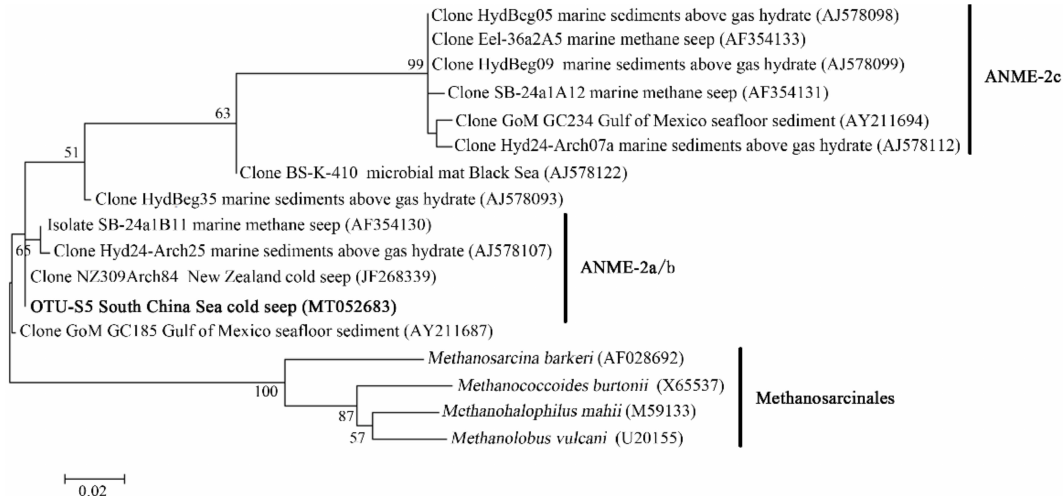
Figure 5. The maximum-likelihood phylogenetic tree based on 16S rRNA gene sequences (391 bp) showingthepositionofOTU-S5fromthisstudy. ClosesequencesfromNationalCenterforBiotechnology Information (NCBI) database were selected to construct the tree. GenBank accession numbers are shown in parenthesis. Only bootstrap values (expressed as percentages of 1000 replications) equal or greater than 50% are shown at the branching points. Scale bar, 0.02 substitutions per nucleotide